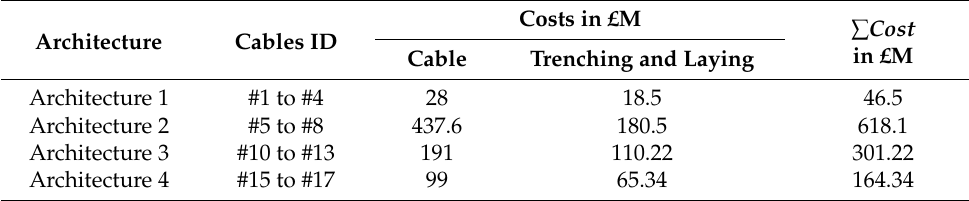
Table 10. AC-cable and trenching cost estimation.